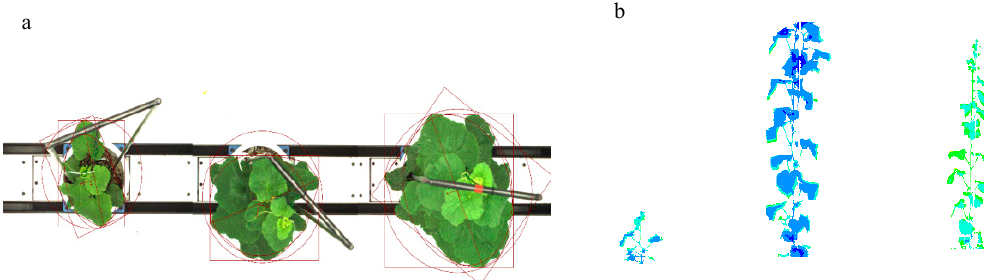
Figure 4. Phenotypic image processing steps. ( a ) Images within visible spectra;( b ) Images within near-infrared spectra. Different colors represent different water contents in plants.